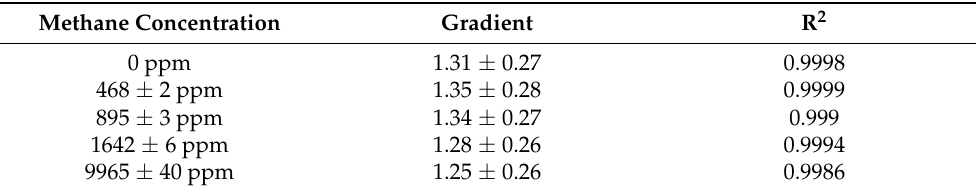
Figure 5. Sensitivity of GA5000 to hydrogen at different methane concentrations where sensitivity is the slope of the GA5000 response vs. theoretical hydrogen concentration curve. Table 3. Results of linear regression between measured and theoretical hydrogen concentrations at different methane concentrations.